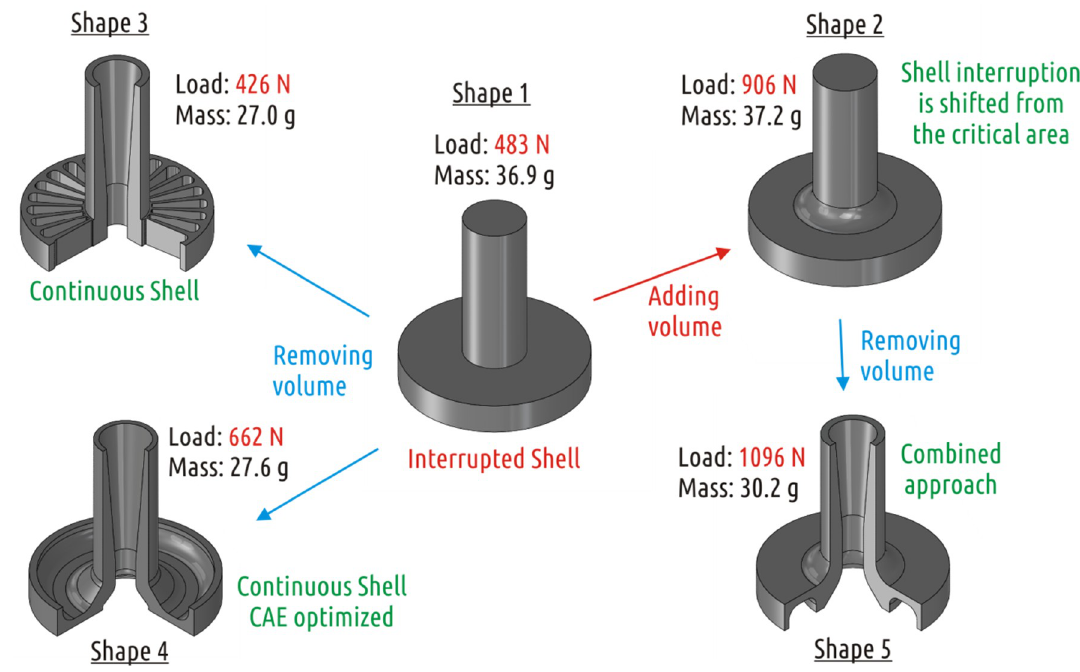
Figure 1. Testing part geometry optimization and results of the study [64] .